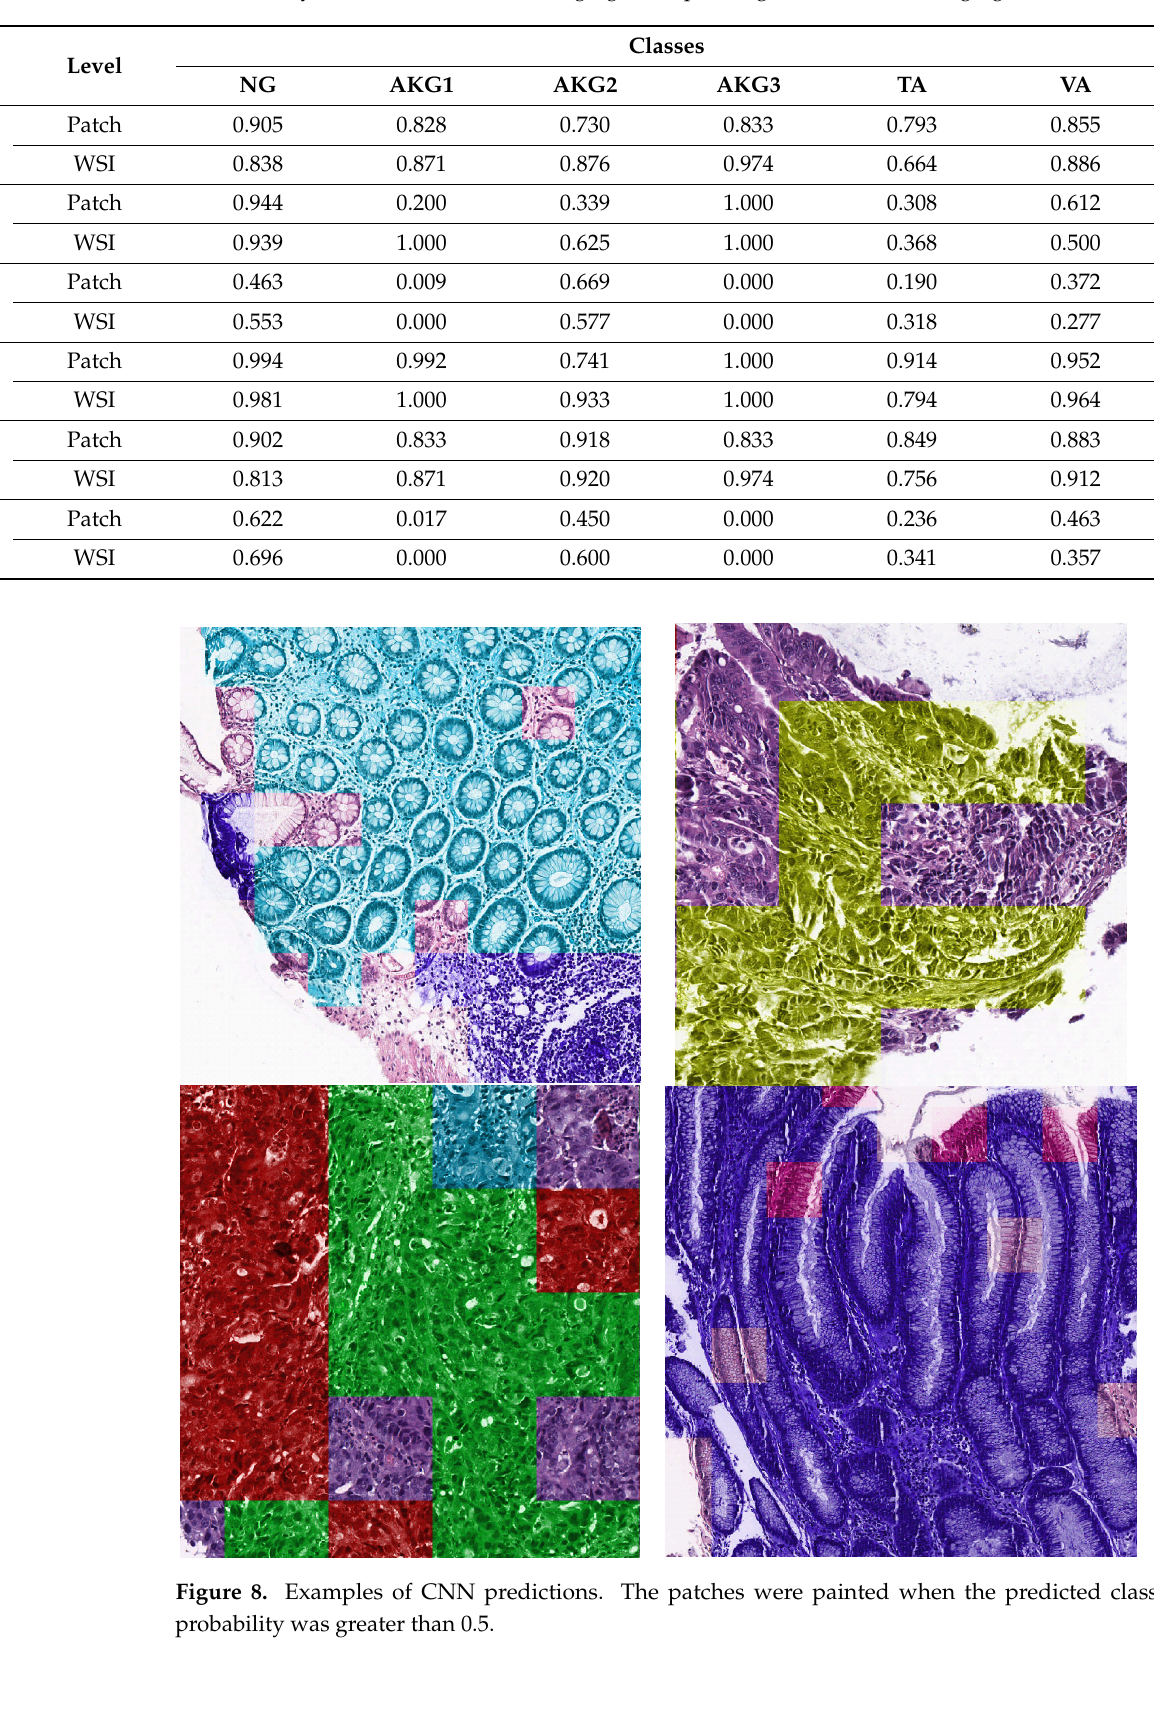
Figure 8. Examples of CNN predictions. The patches were painted when the predicted class proba- bility was greater than 0.5. As an output of our program, we received the probability (the value from 0 to 1) for each of the six tissue types that the patch belonged to. If all the probabilities were below the threshold, we did not assign any class to the patch. In this case, the patch may have belonged to the unknown class. When several classes had probabilities greater than the threshold, the prediction was «mixed»; that is, the patch consisted of several areas belong- ing to different tissue types. It would be inconvenient to analyze the result of the painted WSI if we used special markers for all mixed types. Such patches could be highlighted for the specialist; otherwise, we painted the mixed patches with the color of the most probable type, while the threshold could be chosen by the user.